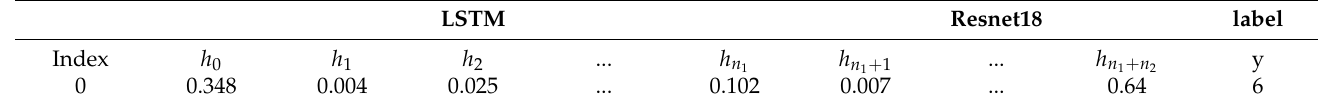
Table 3. Format of the secondary data set.